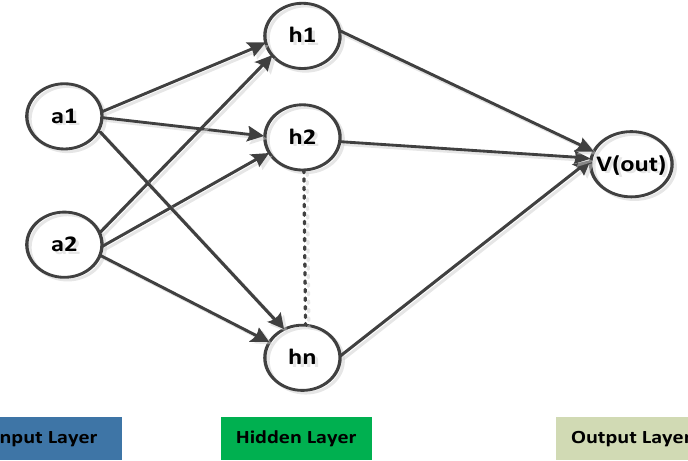
Figure 2. Fundamental structure of the presented BNN model.